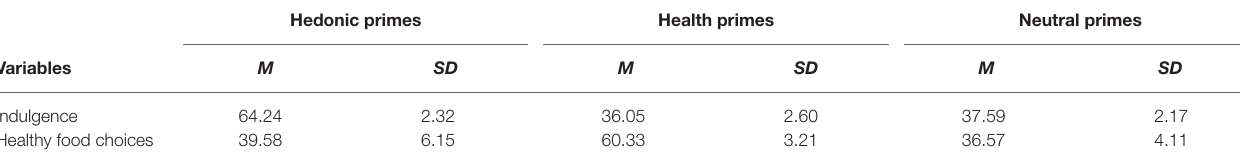
TABLE 2 | Priming pictures rating scores per priming